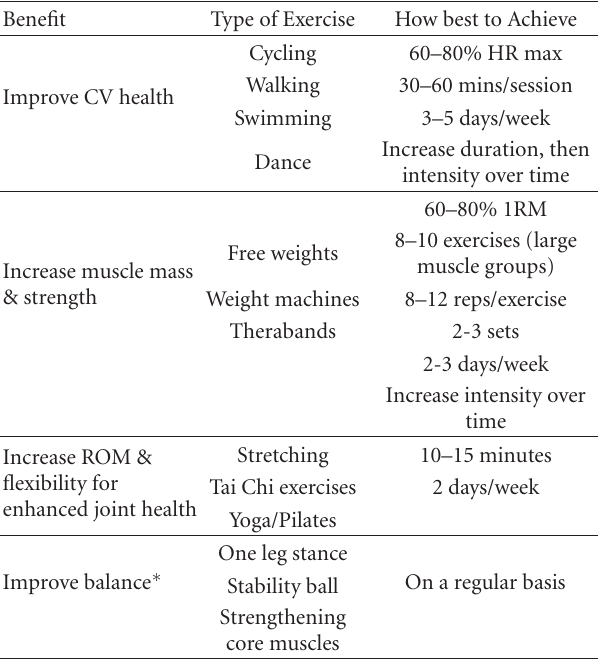
Table 1: Summary of general exercise guidelines for RA. This information is derived from ACSM exercise management guidelines [140] and the research